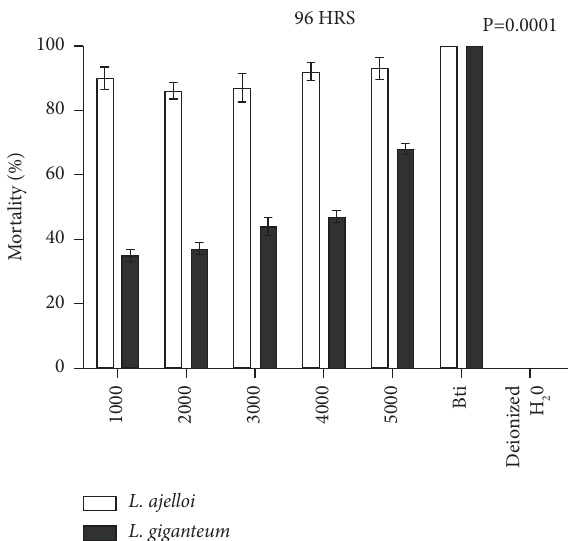
Figure 4: Comparison of percent mortality of Lagenidium giganteum and L ajelloi against A. gambiae larvae at diferent zoospores concentrations and controls. L. ajelloi caused signif- cantly more larval mortalities than L. giganteum in all zoospore concentrations under